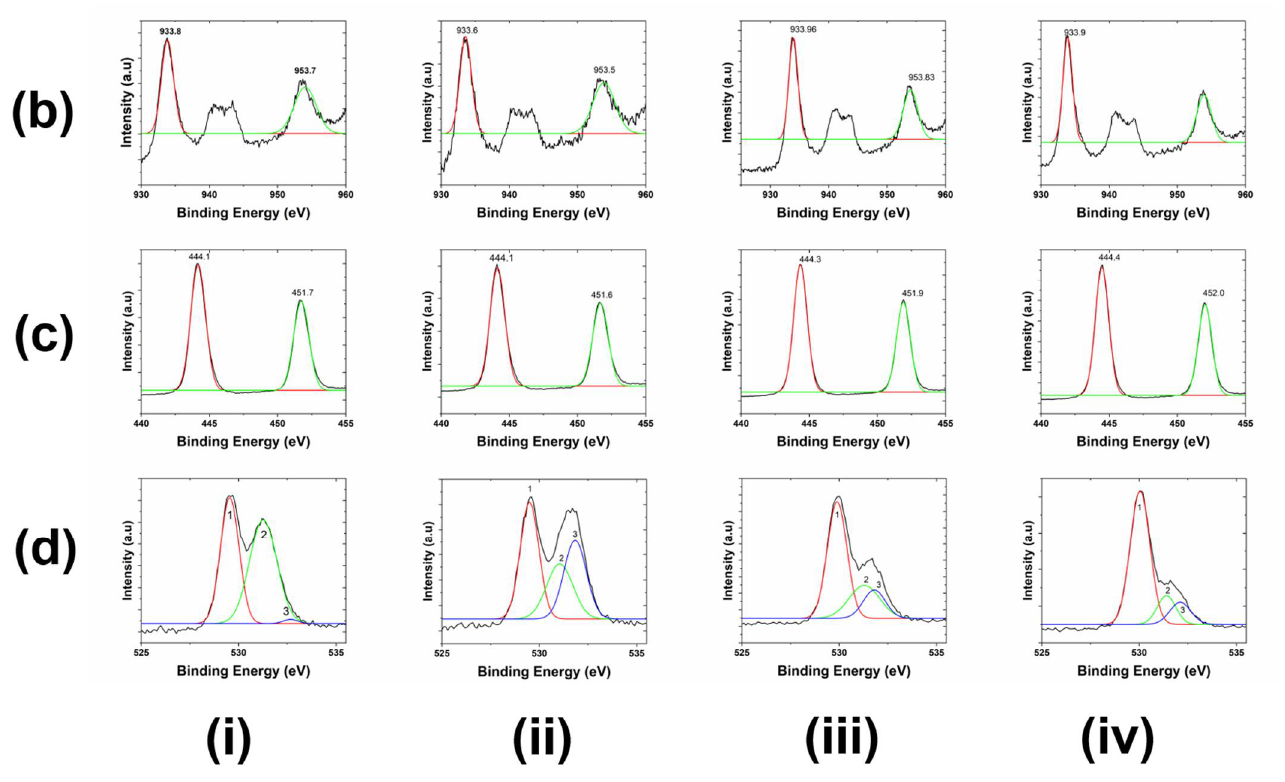
Figure 4. ( a ) XPS spectra of CuInO x thin films with ( b ) copper peaks, ( c ) indium peaks, and ( d ) oxygen peaks. ( i – iv ) correspond to room temperature, 200 °C, 300 °C, and 400 °C, respectively.